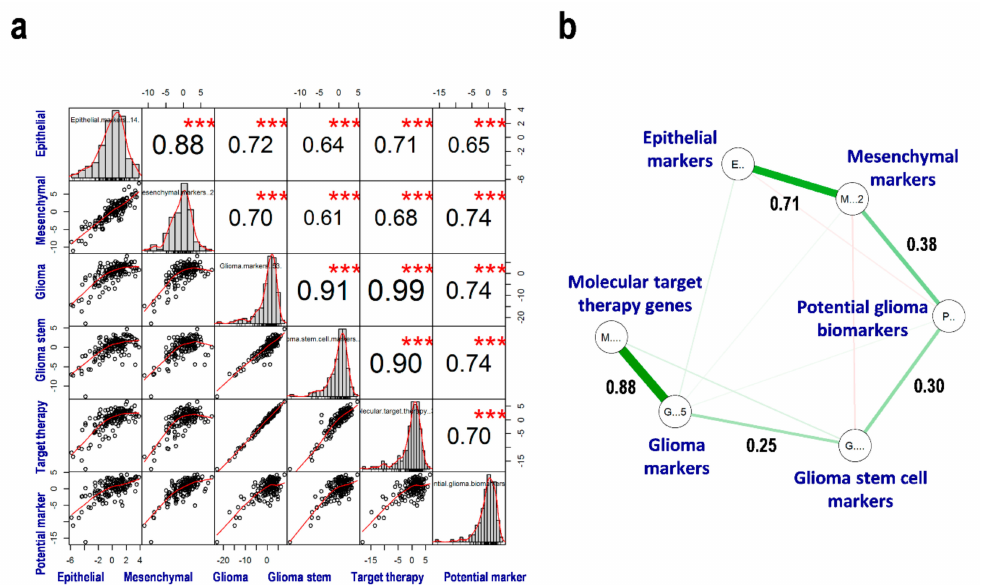
Figure 4. Correlation among the gene sets in glioblastoma. ( a ) Score correlation in glioblastoma. ( b ) The graphical lasso estimation with the network model of the gene sets related to epithelial–mesenchymal transition and glioma in glioblastoma. *** p <